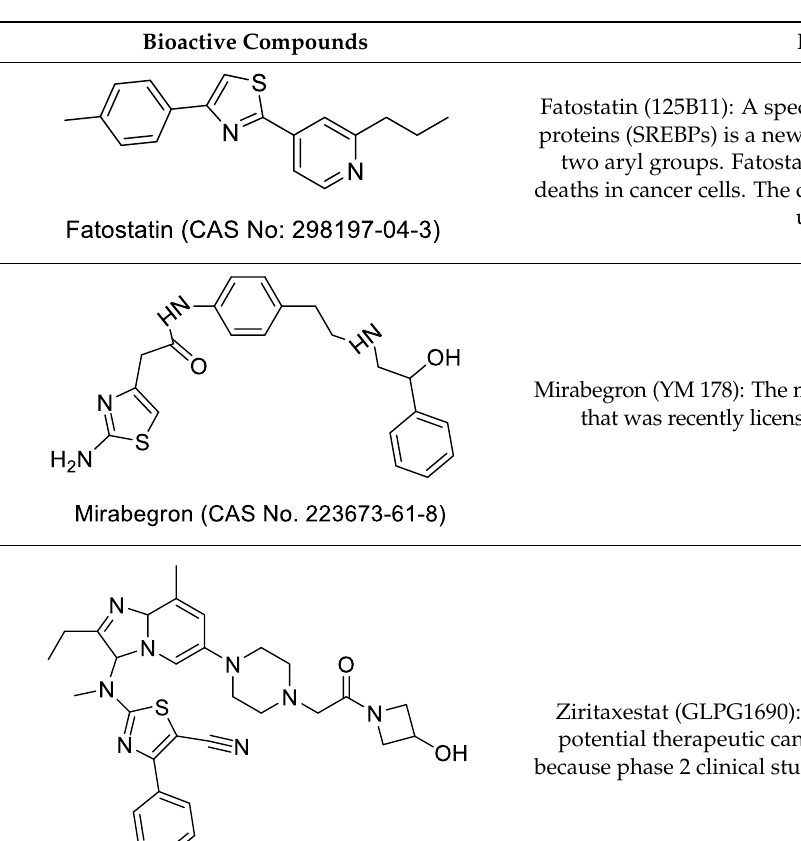
Table 1. Thiazole-ring-bearing drug candidates under intensive preclinical/clinical investigations.